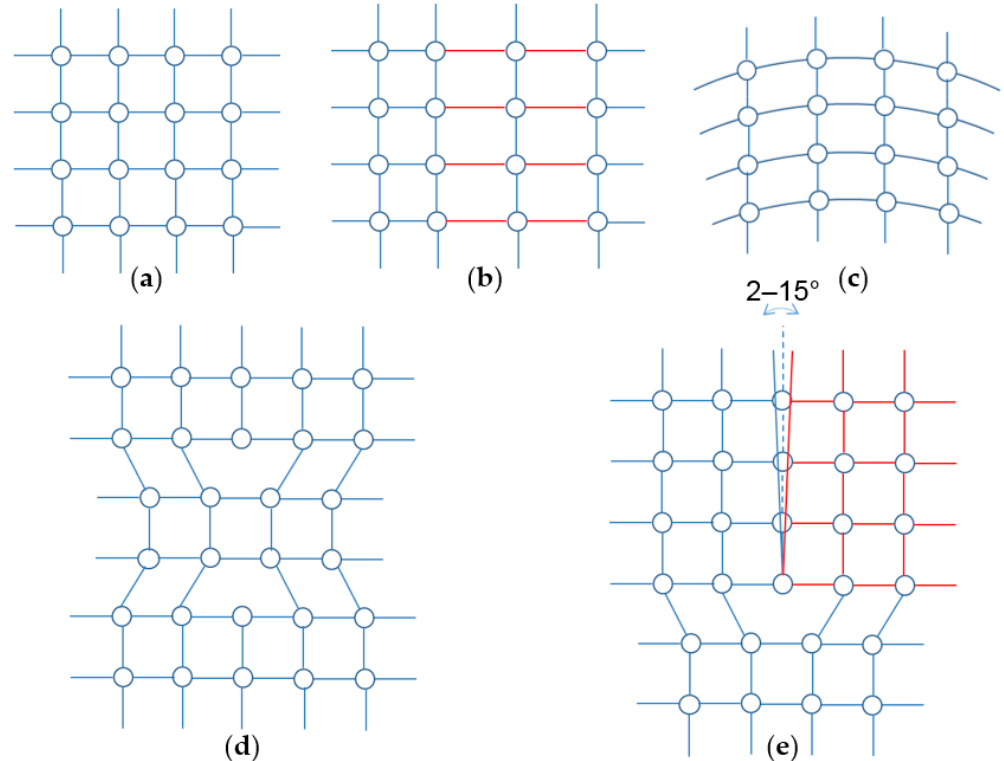
Figure 5. Schematic diagrams of ( a ) a regular crystal lattice; ( b ) a strained lattice with uniaxial lengthened bonds; ( c ) a bent lattice; ( d ) a distorted lattice with symmetric vacancy defects; and ( e ) a lattice with a subgrain boundary.